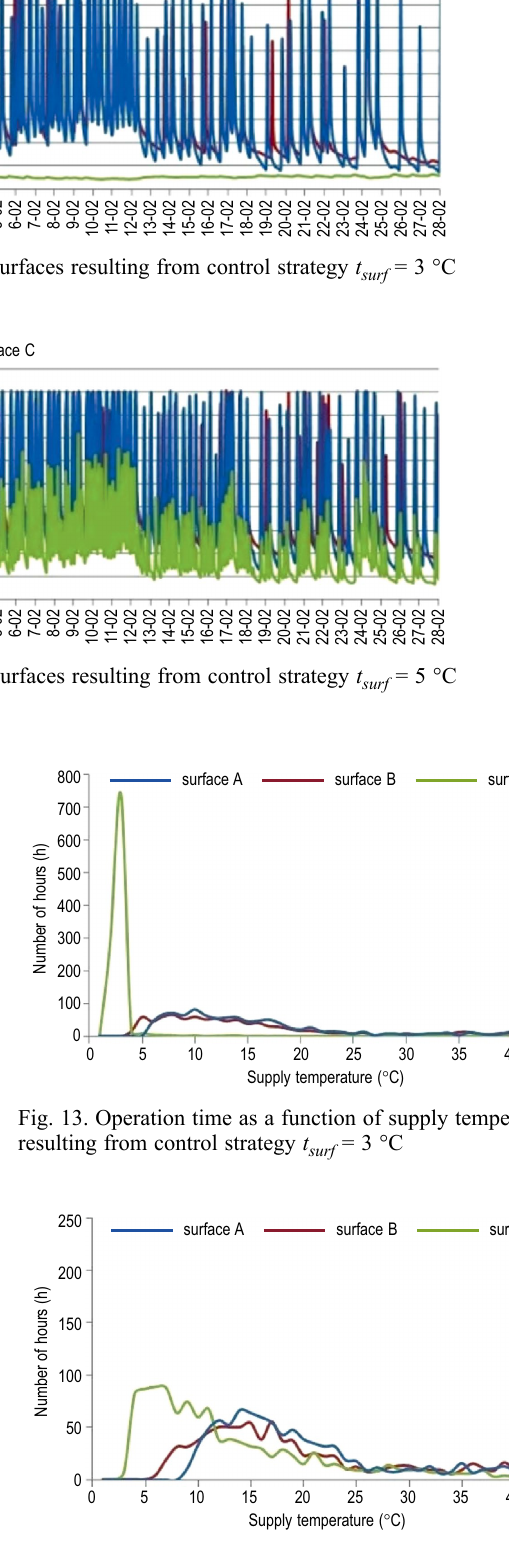
Fig. 14. Operation time as a function of supply temperature resulting from control strategy t surf = 5 °C